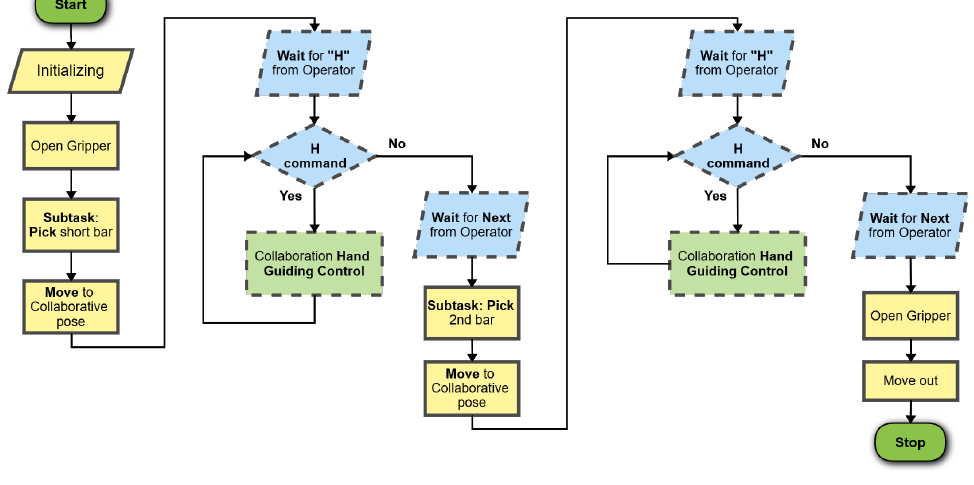
Figure 11. The robotic task